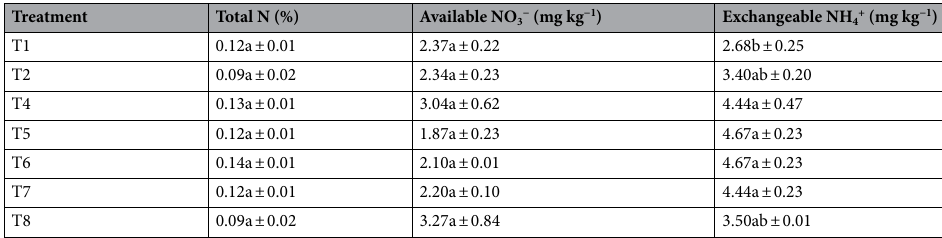
Table 5. Soil nitrogen concentrations measured after harvesting using chemical analysis method in the second planting cycle. Different letters within a row indicate significant difference between means of four replicates ± standard error using Tukey’s test at P ≤